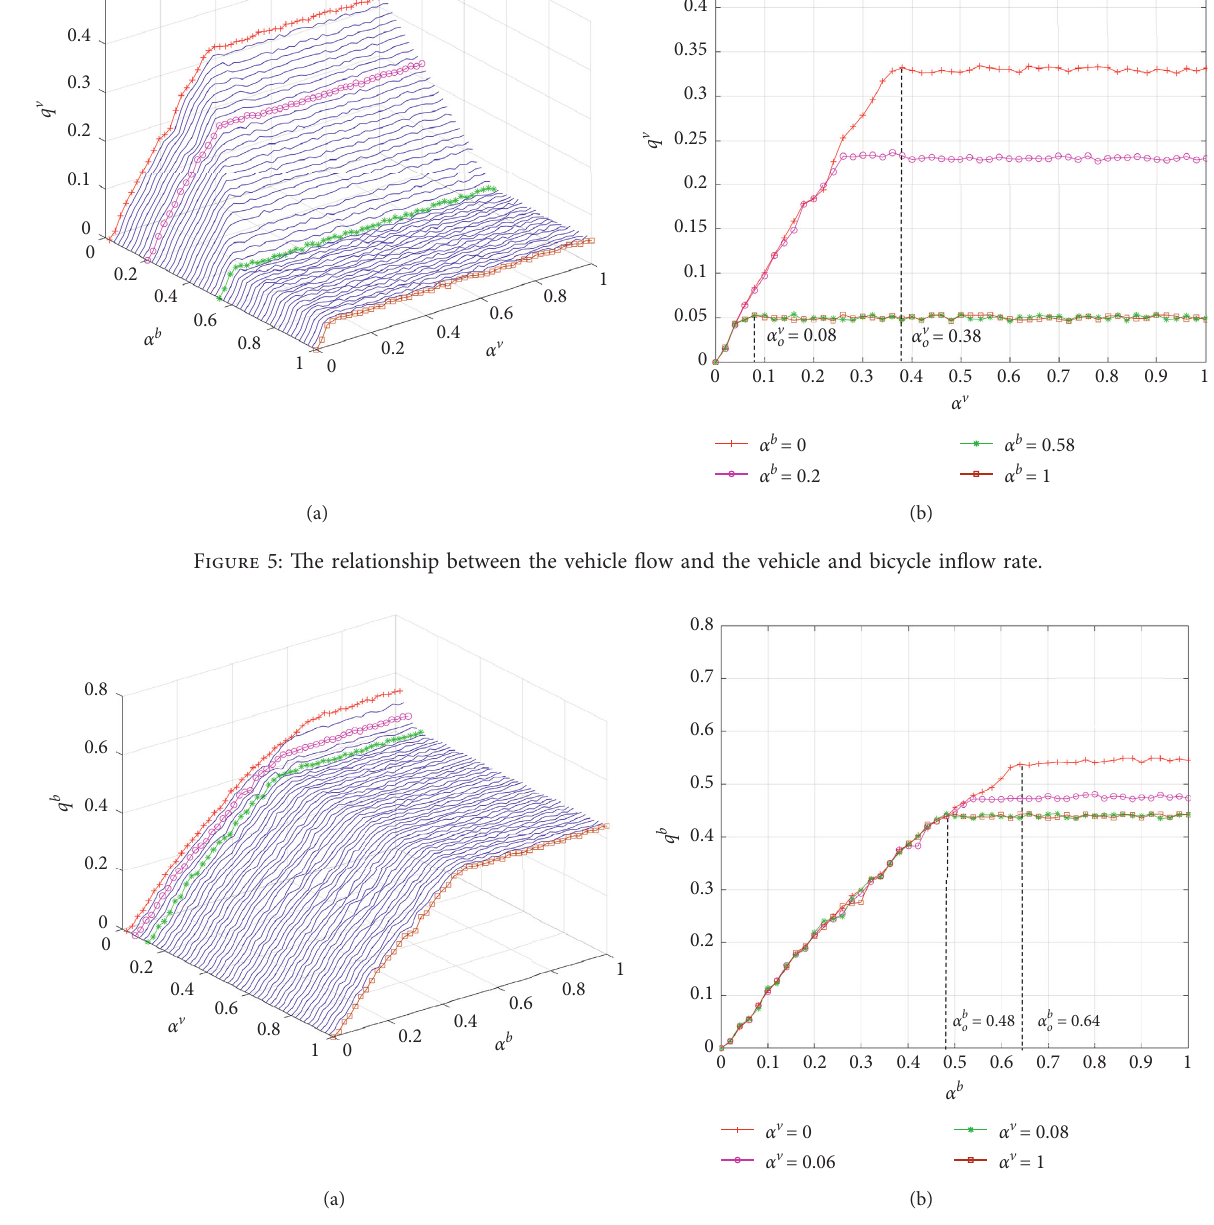
Figure 6: The relationship between the bicycle flow and the vehicle and bicycle inflow